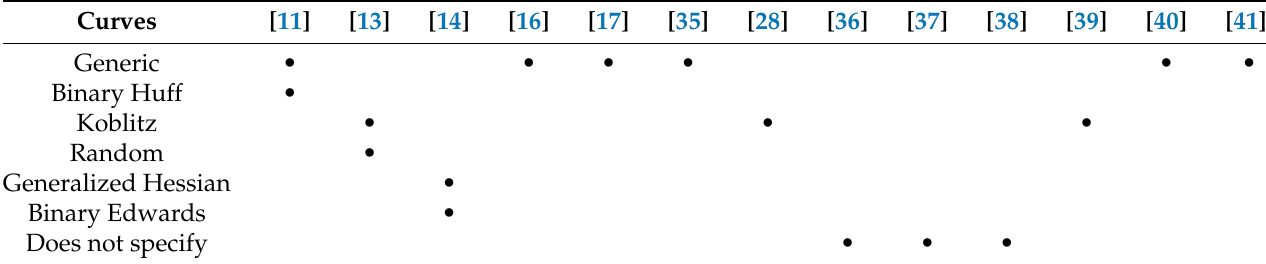
Table 4. Summary of implemented curves.